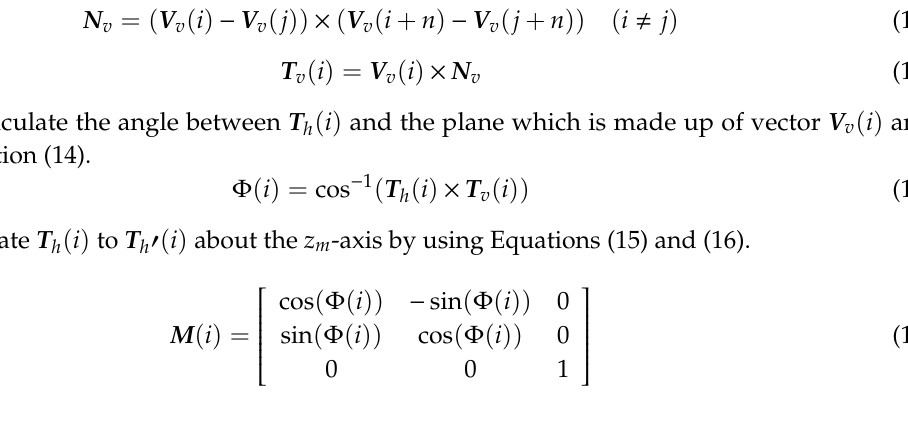
Figure 4. The diagrams of measured data and auxiliary data.